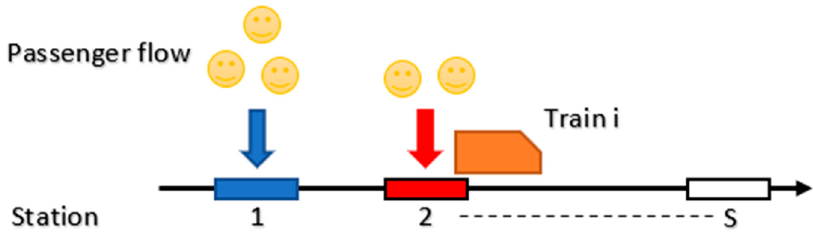
Figure 1. System Figure 1. System description.